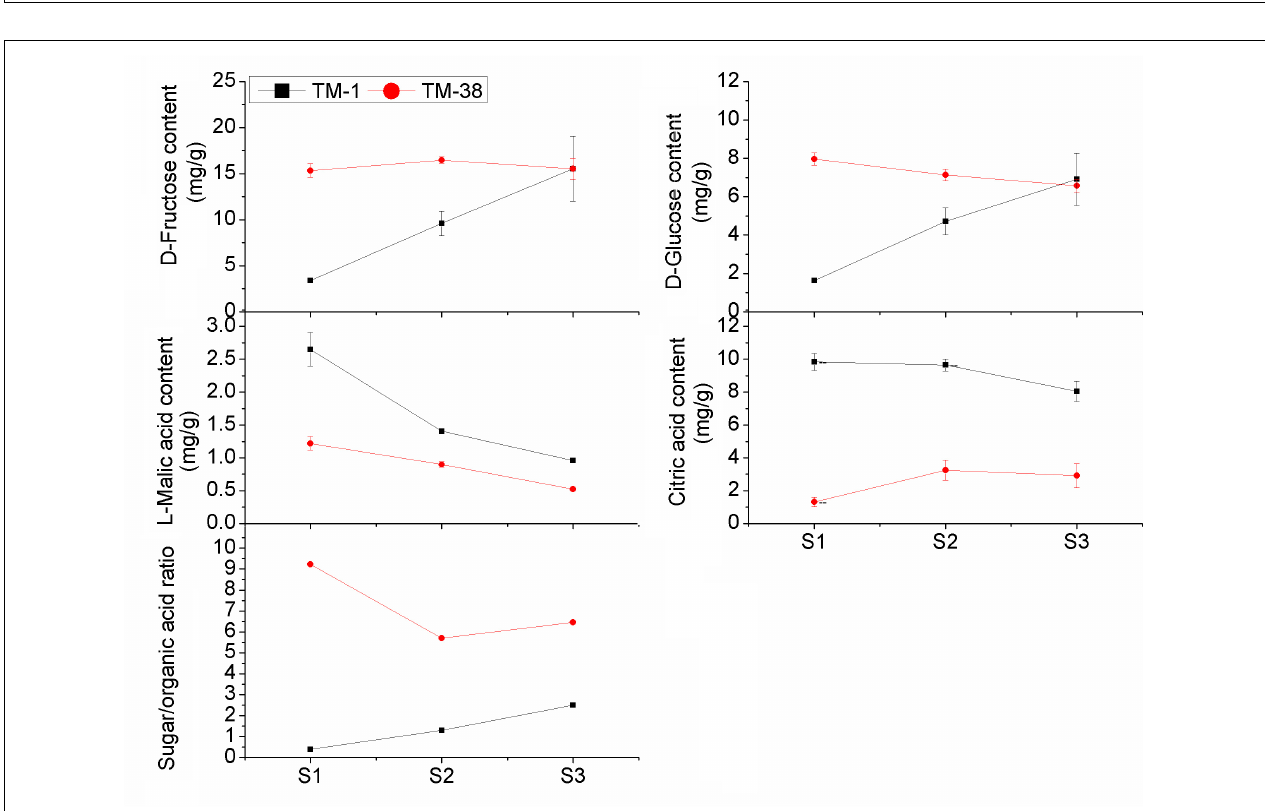
FIGURE 2 | Developmental profiles of D-fructose, D-glucose, L-malic acid, citric acid contents, and the sugar/organic acid ratio in TM-1 and TM-38 at three developmental stages. Values are means ± SE.